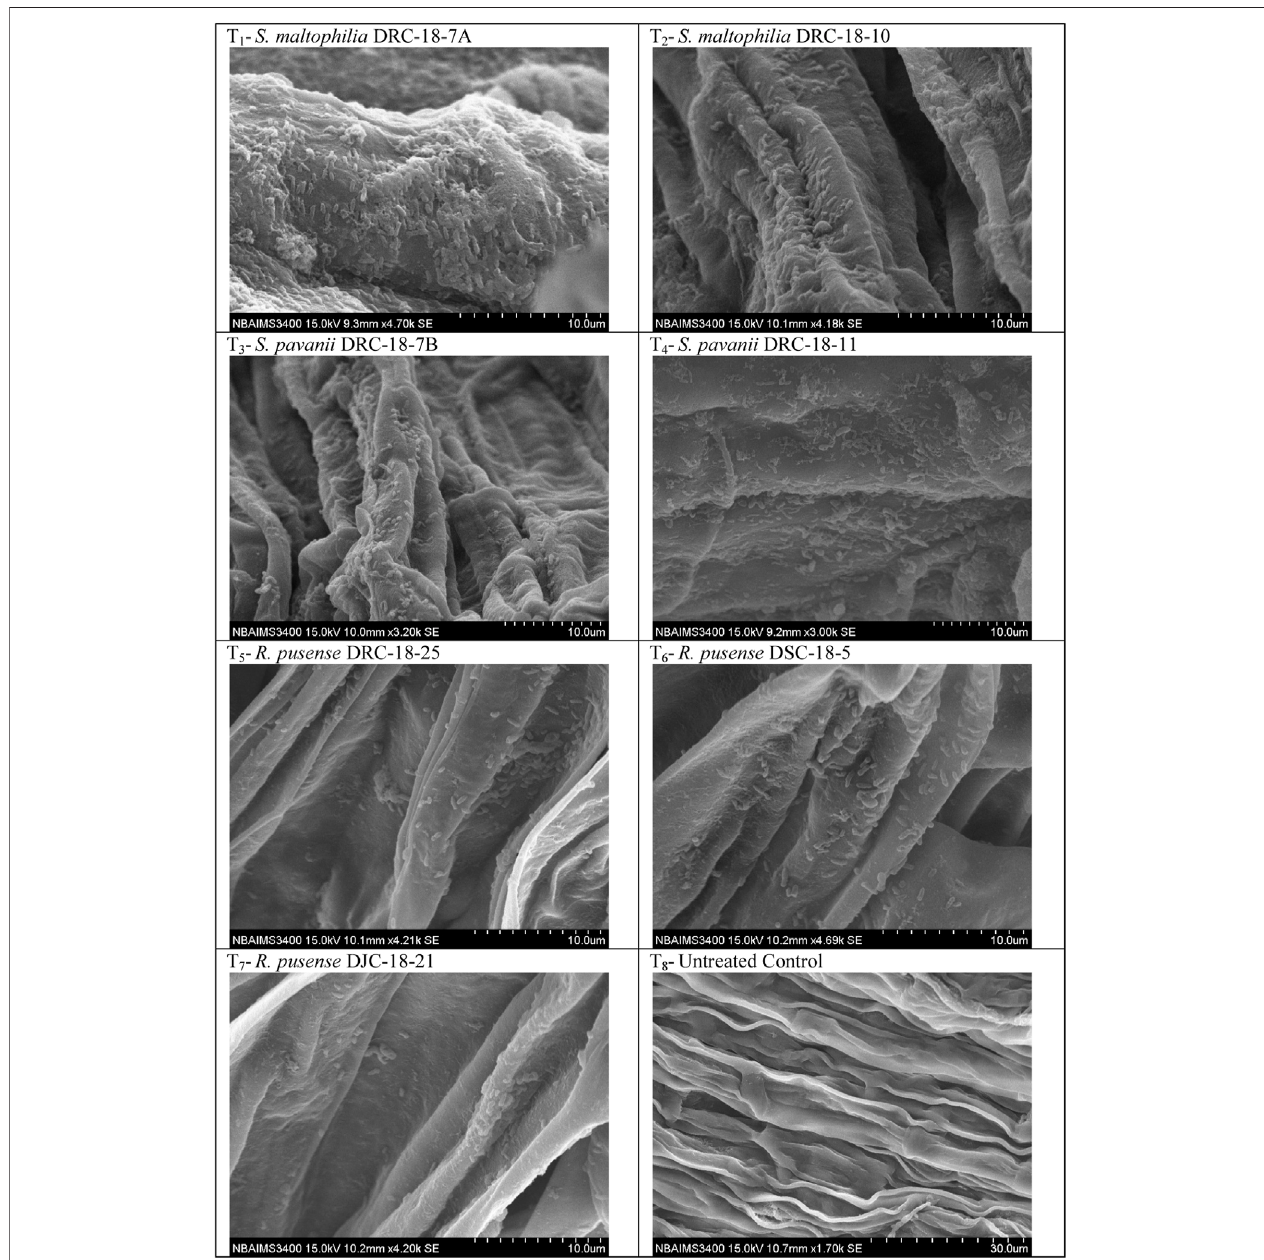
FIGURE 4 | Scanning electron microphotographs showing root colonization of selected strains of SOB at 15 days of sowing.